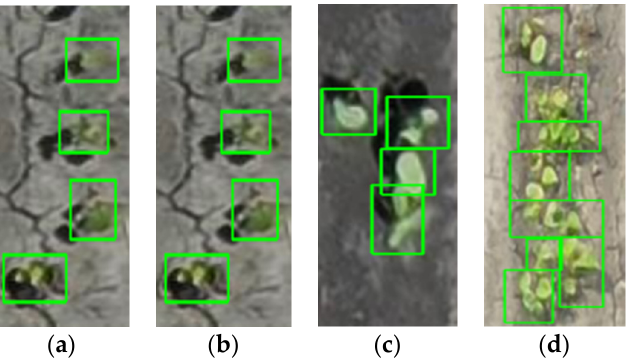
Figure 9. Examples of manually labeled data on April ( a ) 15, ( b ) 16, ( c ) 18, and ( d ) 24. Note: These examples represent different locations of the experimental field with different zoom levels.